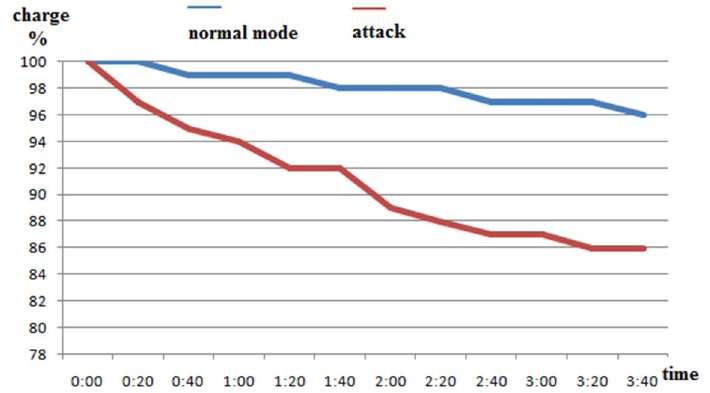
Figure 2. Tracing of vector of ERE attack on the Nexus 5.